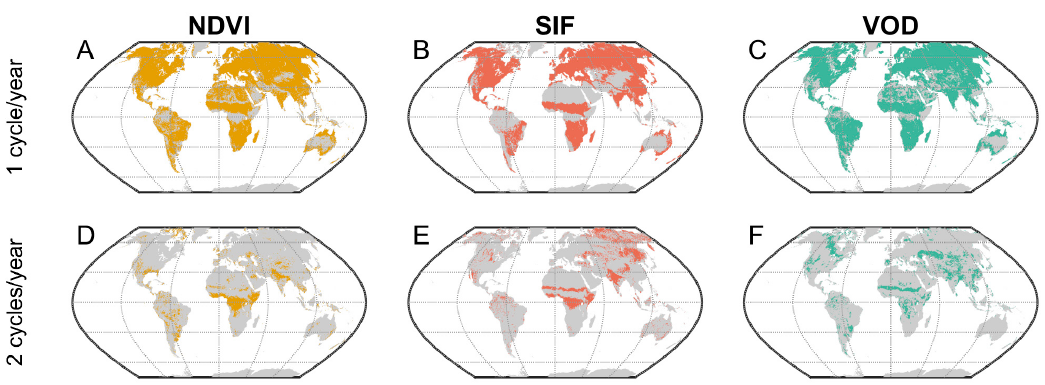
Figure 7. Number of significant annual phenological cycles per year for each index. ( A – C ) Pixels with one distinct annual phenological cycle per year in the monthly NDVI (yellow), SIF (red), and VOD (green) data. ( D – F ) Pixels with two distinct annual phenological cycles per year in the monthly NDVI, SIF, and VOD data. Note that these are not mutually exclusive categories, so a given pixel can have a significant biannual phenological cycle overlain on an annual phenological cycle (e.g., Figure 2). Significance of (bi)annual phenological dynamics was defined as the observed PSD from the MTM test exceeding the 99 th percentile of PSDs from a noise-only ensemble.